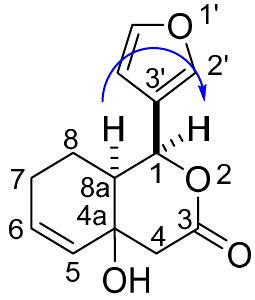
Figure 5. Key n.O.e. correlations for (±)- 3a .